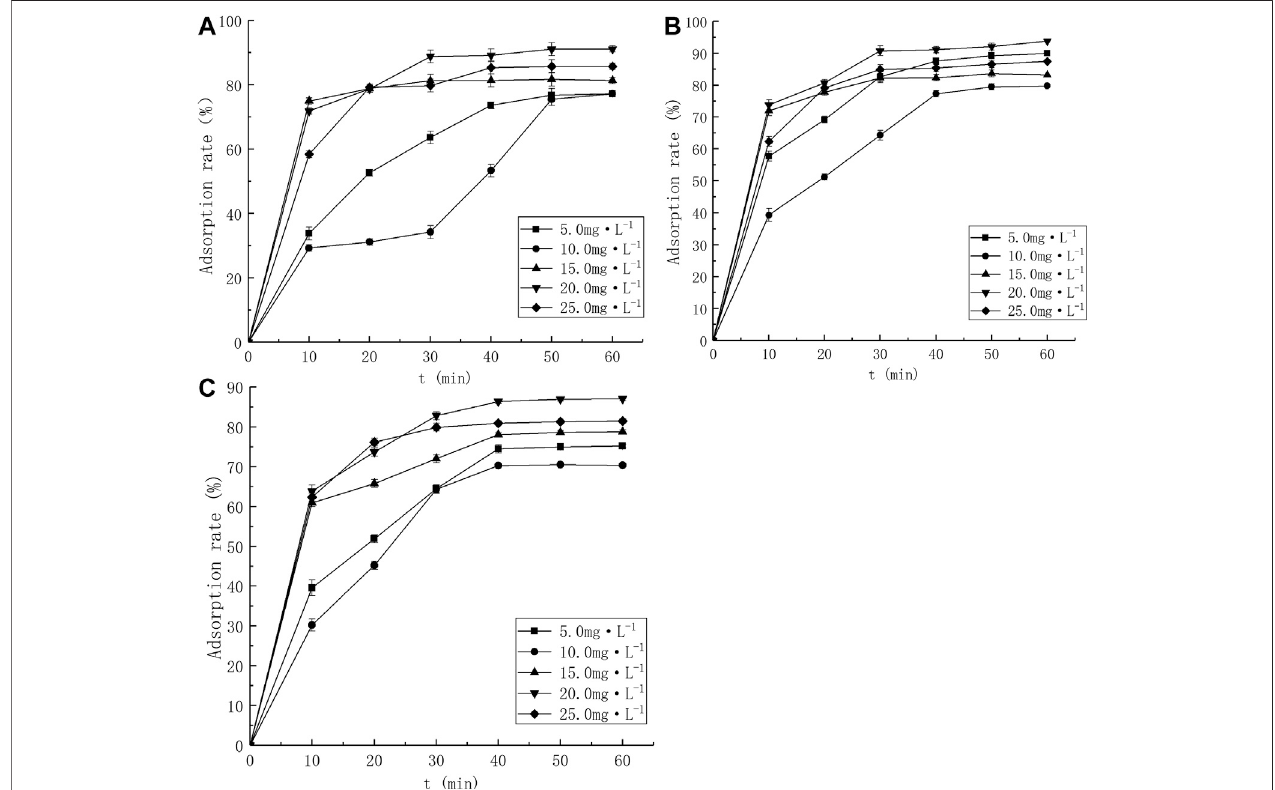
FIGURE 5 | Effect of reaction time on Pb 2+ adsorption. (A) : BC, (B) : CTS-BC, (C) : BC-CTS.